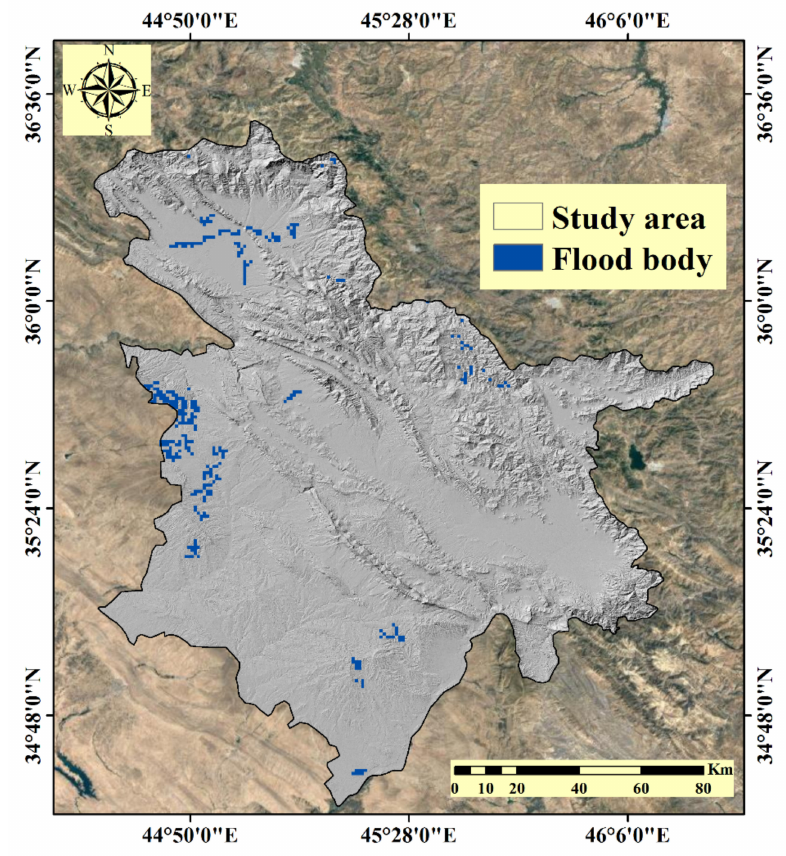
Figure 3. Flood monitoring using Sentinel-1